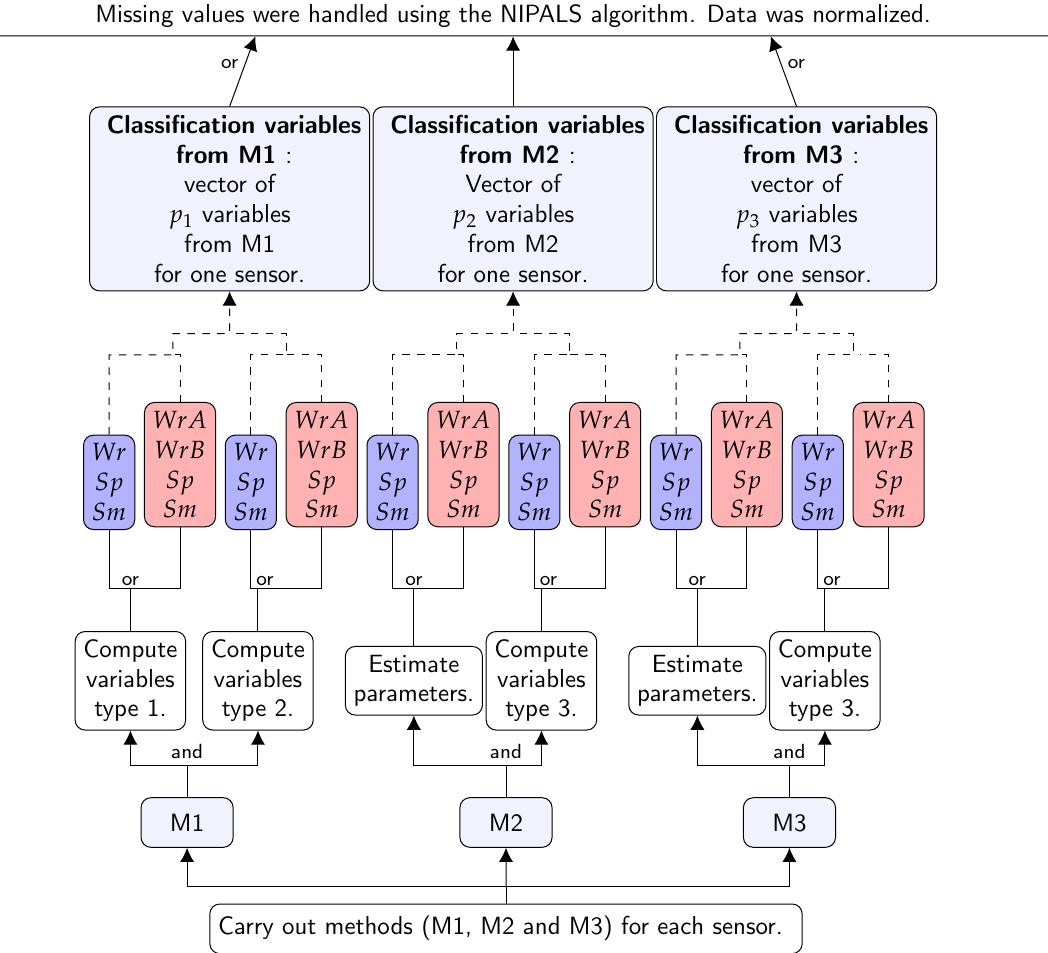
Figure 9. Flow chart for the stages used to apply sparse partial least squares discriminant analysis (sPLS-DA) to the results from the three methods. In the box titled “Data”, the information corresponds to the variables from one of the three methods. If the information is from M i then X = X i . The values were computed for all sensors. Thus, a matrix X was obtained. The values were treated before running the sPLS-DA algorithm. In the box titled “Data input for sPLS-DA”, the information corresponds to the response vector converted into a dummy matrix Z . In the following boxes the PLS-DA algorithm runs from left to right. The first three-fold CV was used to evaluate PLS-DA and the prediction distance PD, classification error rate (CER) with the optimal number of components selected. This information was used in the second three-fold CV to check PLS-DA in order to select the optimal number of variables V. The information obtained using both three-fold CVs was used to run the final